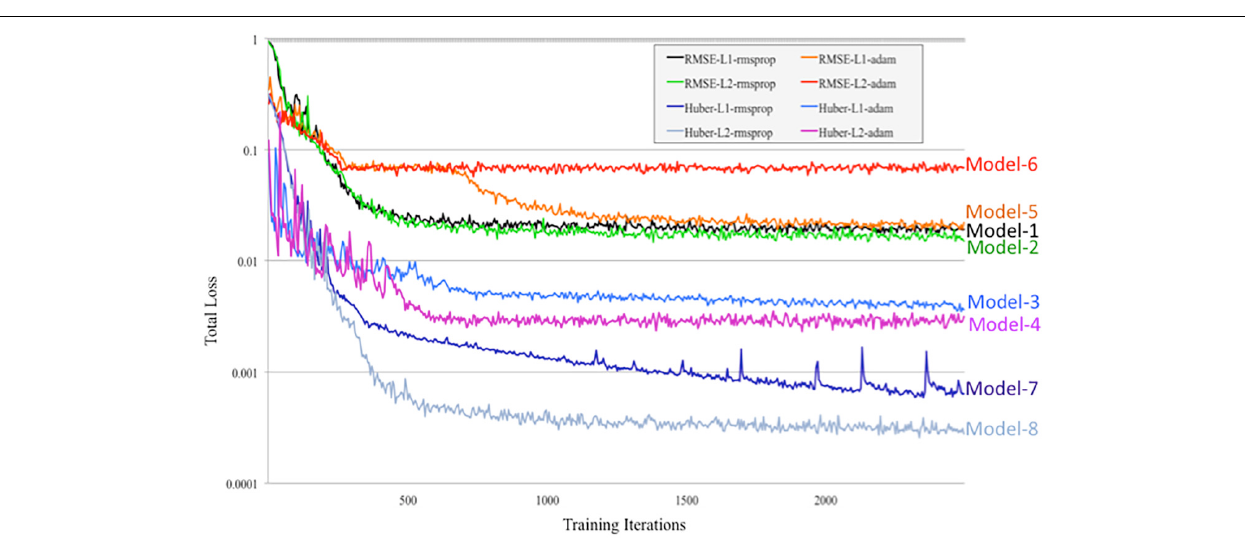
FIGURE 7 | Tensorboard training learning curves for DeepNavNet Models 1-8 using hyperparameters described in Table 1